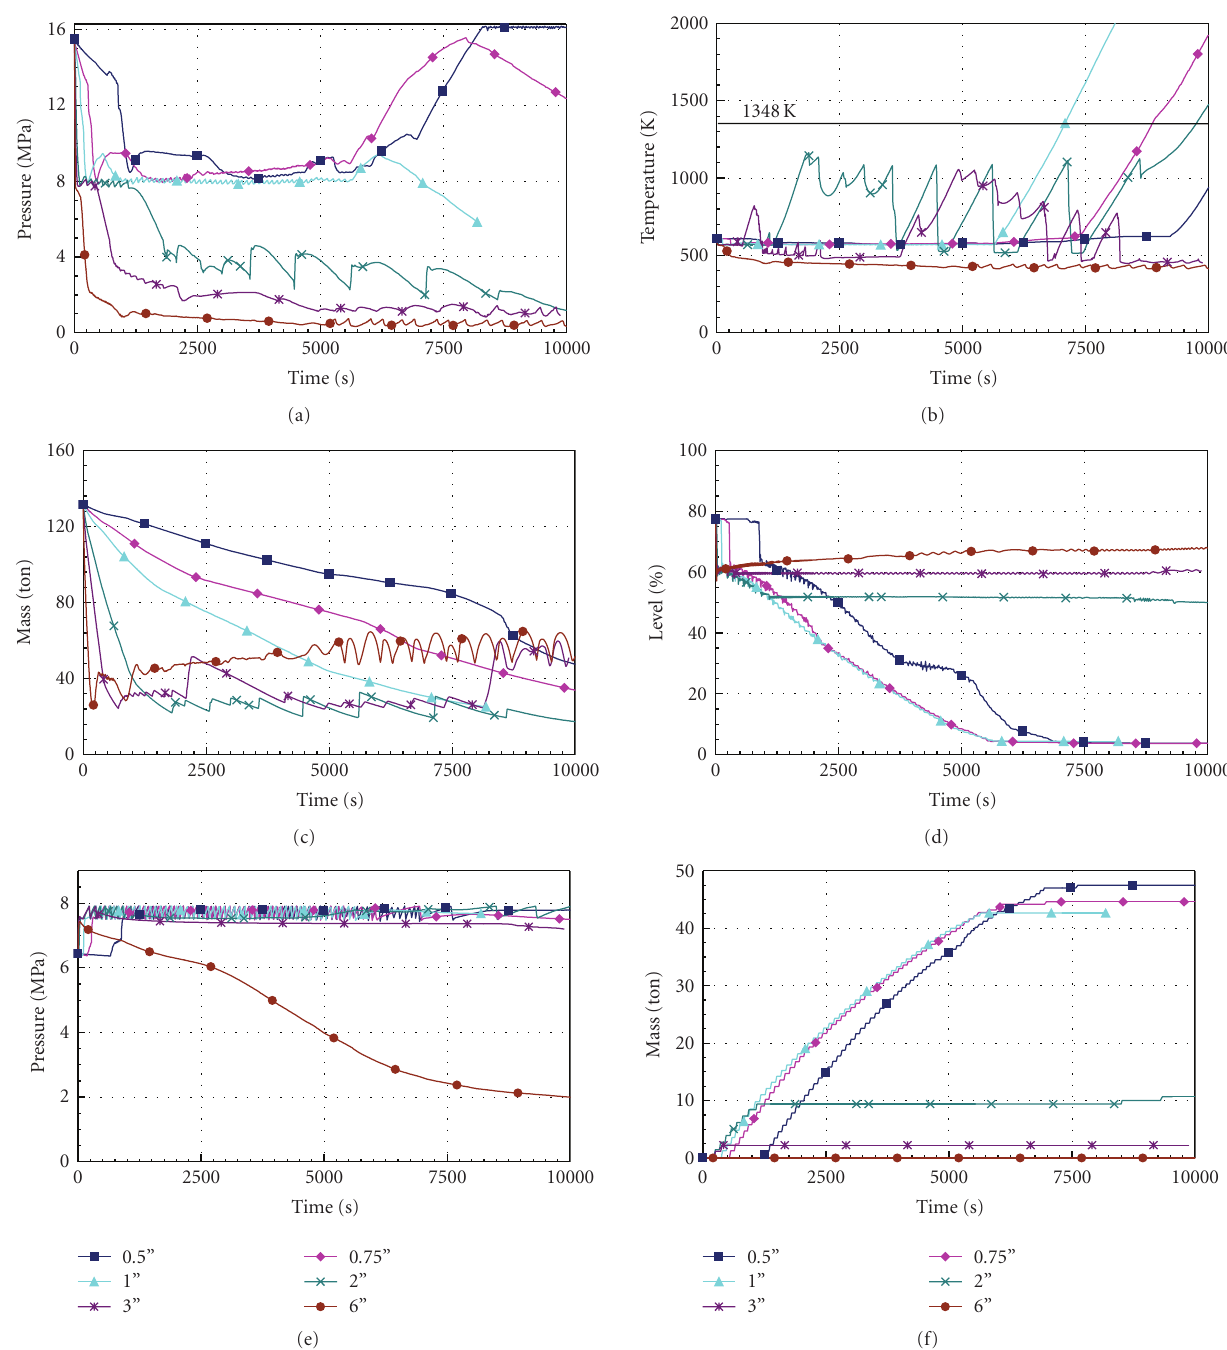
Figure 2: Calculated results for spectrum of break sizes: (a) RCS pressure, (b) core cladding temperature, (c) RCS mass inventory, (d) SG no. 1 wide range level, (e) SG no. 1 pressure, (f) mass discharged through SG no. 1 PORV.